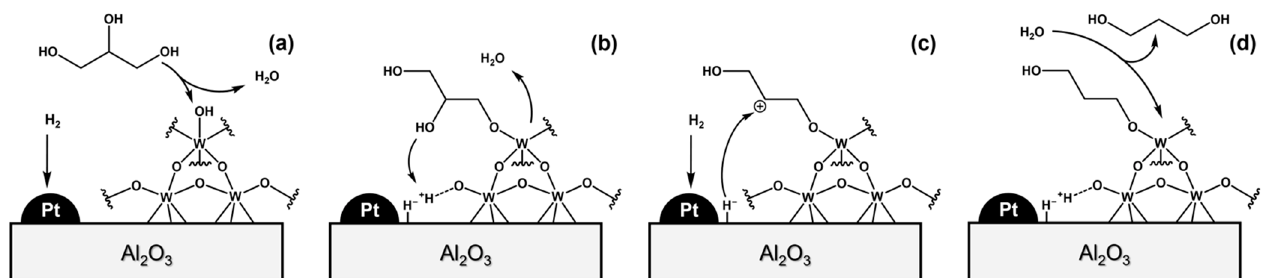
Figure 7. Reaction mechanism proposed for glycerol hydrogenolysis to 1,3-propanediol (1,3-PDO) over a Pt/WO x supported on alumina. In brief: ( a ) glycerol coordination on WO x via first water molecule elimination and H 2 heterolitic splitting over Pt NPs; ( b ) second water molecule elimination via formation of carbocation; ( c ) carbocation reduction through the interaciton with spillovered H − , beared onto Al 2 O 3 support; ( d ) 1,3-PDO desorption and W–OH active site restoration through water splitting.